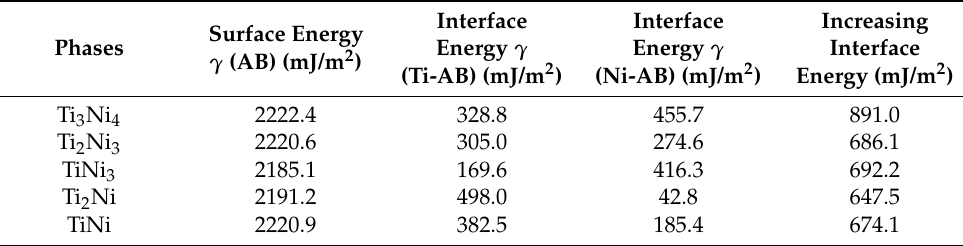
Table 1. The increasing interface energies of different first formation phases.